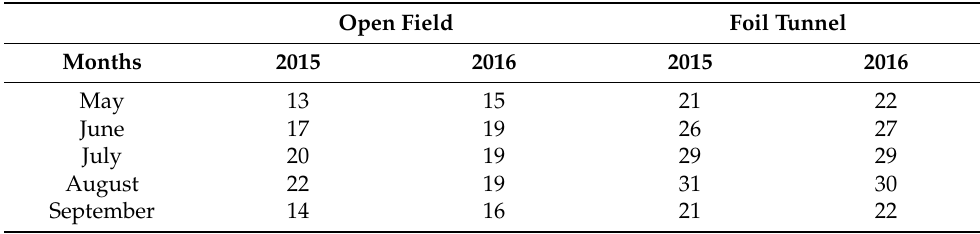
Table 1. Mean temperatures in the vegetation seasons ( ◦ C).